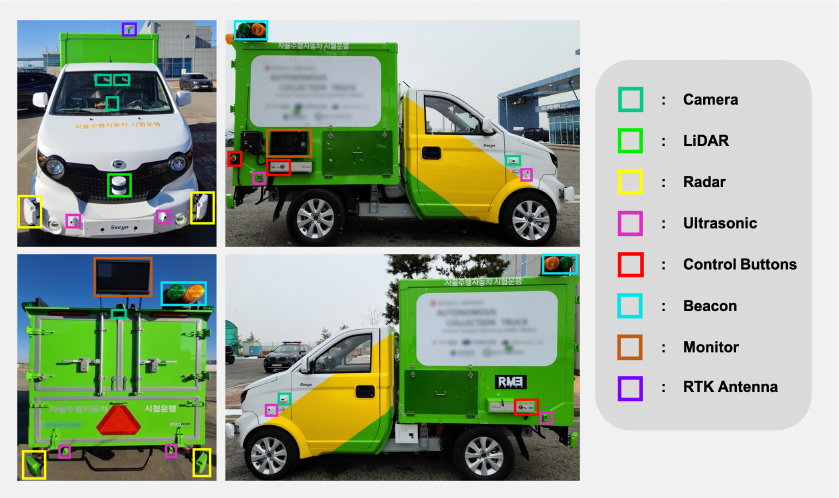
Figure 2. Hardware